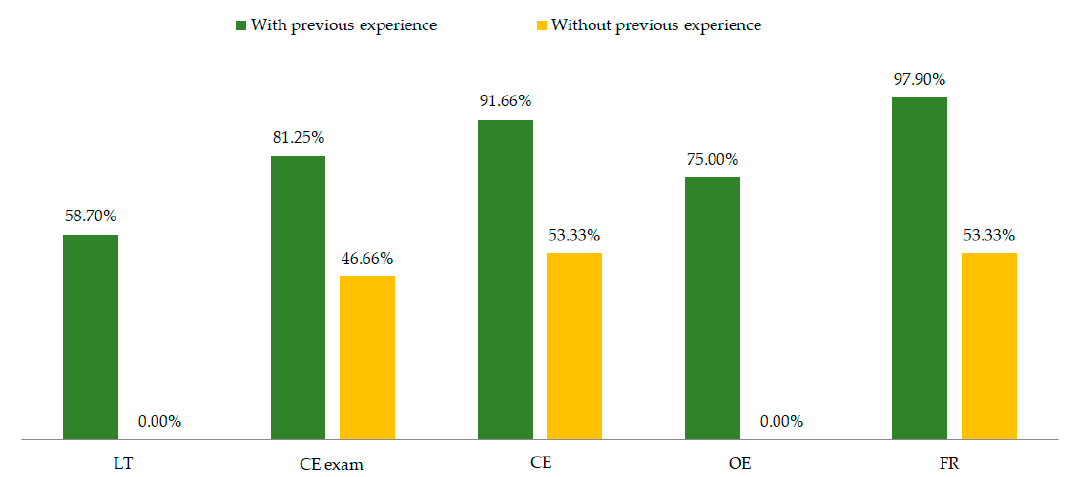
Figure 3. Compared results of different exams separated by students with and without previous experience.